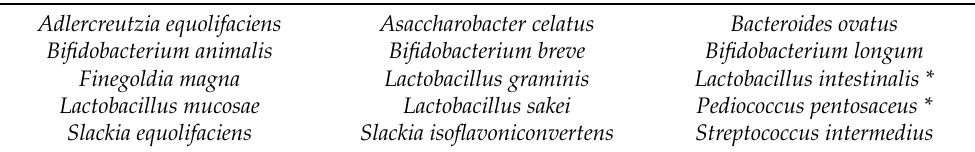
Twenty and 12 from MIU and control groups, respectively. * Not detected in control group.